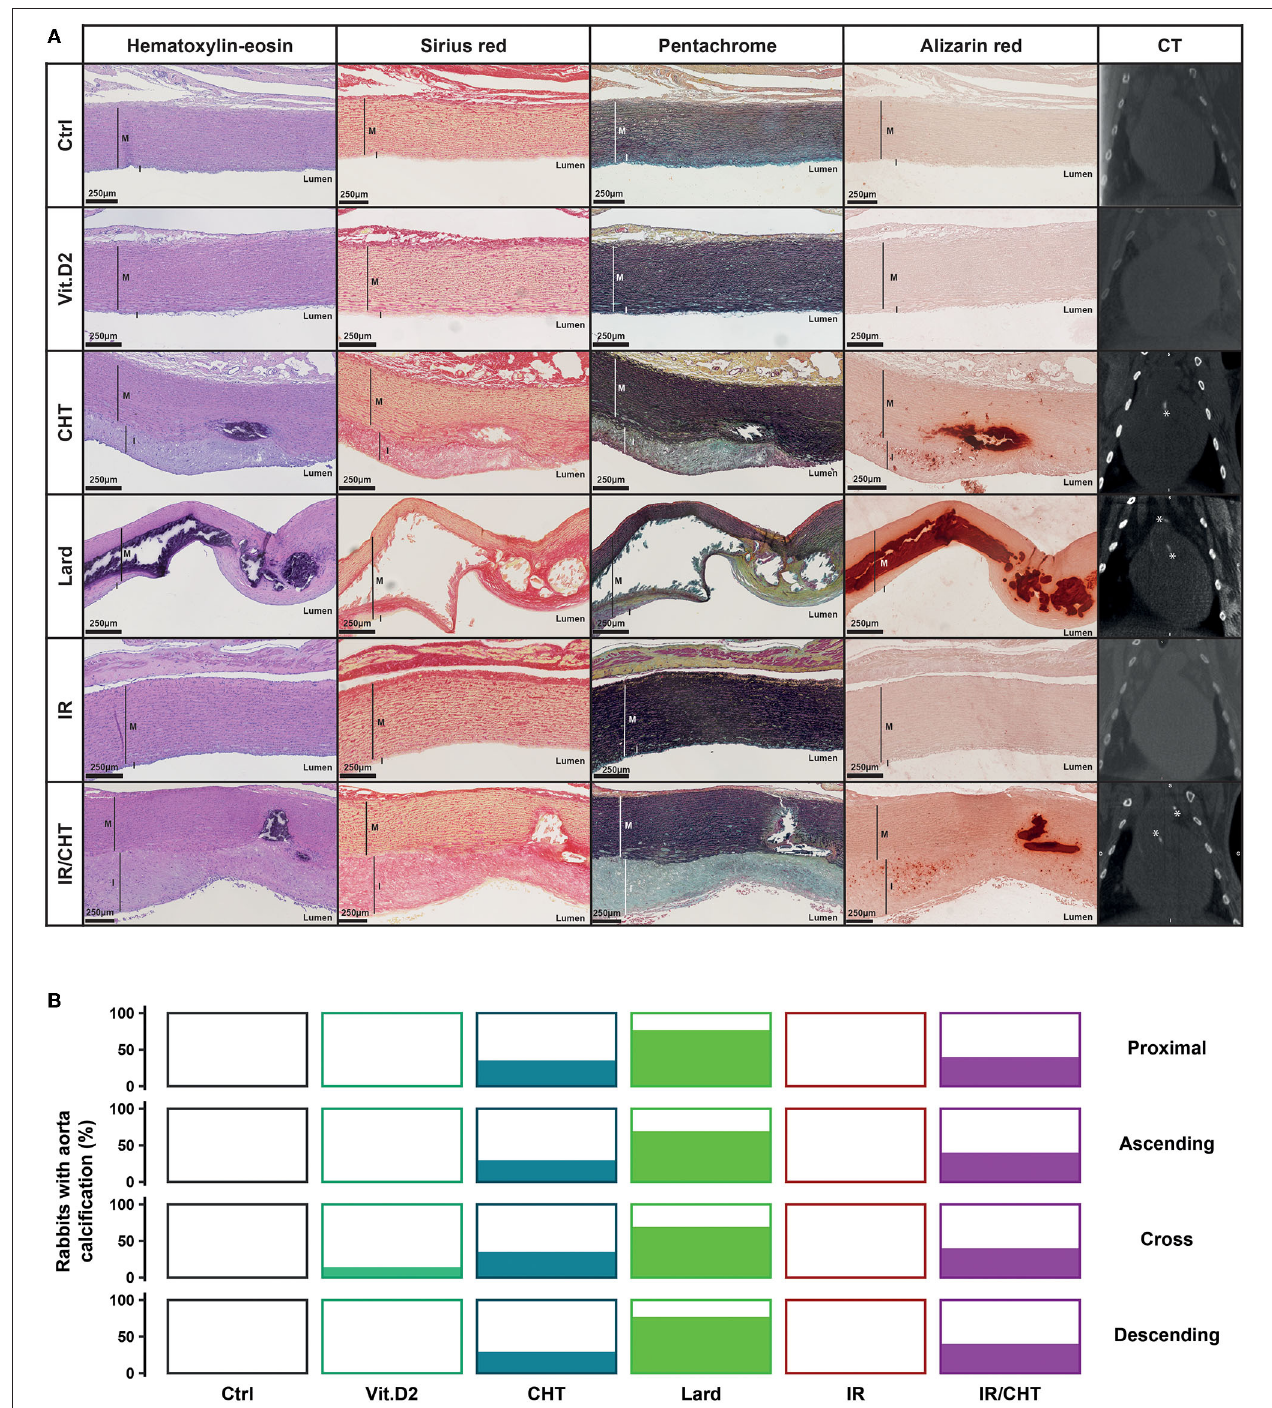
FIGURE 1 | Effect of lard- and cholesterol-enriched diets on the aorta structure. (A) Representative pictures of aortic wall sections stained with hematoxylin-eosin, sirius red, Movat’s pentachrome, and alizarin red, and CT imaging per rabbit group as indicated. Scale bars = 250 µ m. Calcifications observed by CT are indicated by asterisks. (B) Percentage of rabbits from each group that presented CT-detected calcification in the different portions of the aorta (Ctrl, n = 13; Vit.D2, n = 7; CHT, n = 17; Lard, n = 13; IR, n = 7; IR/CHT, n = 15). I, indicates intima; M, indicates media.